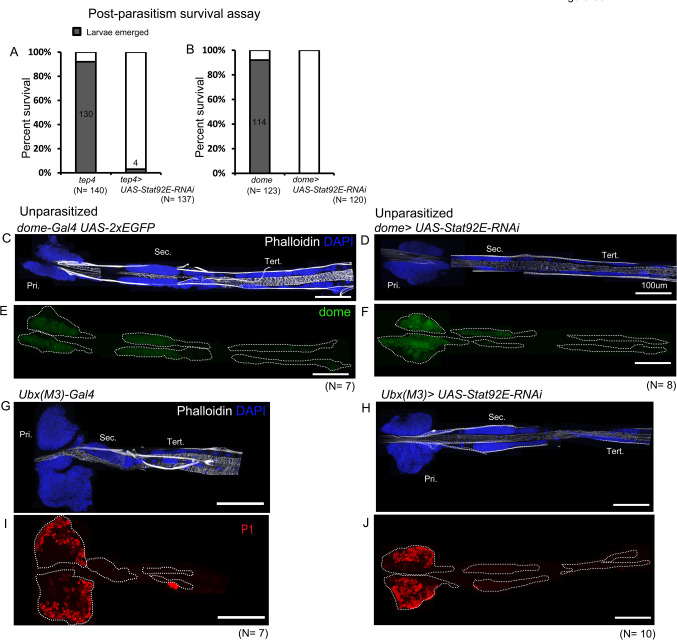
Stat92E is essential for survival post-parasitism.(A and B) Percentage of survival in Stat92E perturbed conditions post-parasitism. (C–J) Targeted knockdown of Stat92E in unparasitized conditions is shown. (C–F) Stat92E knockdown in the progenitors does not lead to lamellocyte differentiation as revealed by phalloidin staining (white) (C and D) and does not affect the progenitor pool as indicated by dome-Gal4,UAS-2xEGFP (green) expression (E and F). (G–J) Posterior progenitors (PP) specific knockdown of Stat92E does not induce lamellocyte and plasmatocyte differentiation in the posterior lobes. Pri. indicates primary lobes, Sec. indicates secondary lobes, and Tert. indicates tertiary lobes. (C–J) Scale bar: 100 µm.